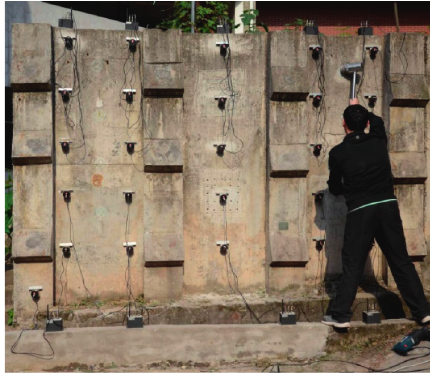
Figure 1: Vibration tests on the pile plate retaining wall. Table 2: The geometrical parameters of the